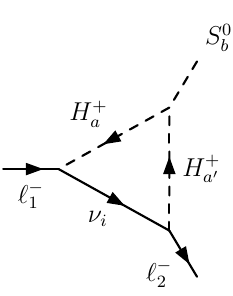
with the neutral scalar attaching to two charged scalars. → ‘ + ‘ − 1 2 b 1 = √ (cid:16) 2 m 2 − m 2 ‘ 1 ‘ 2